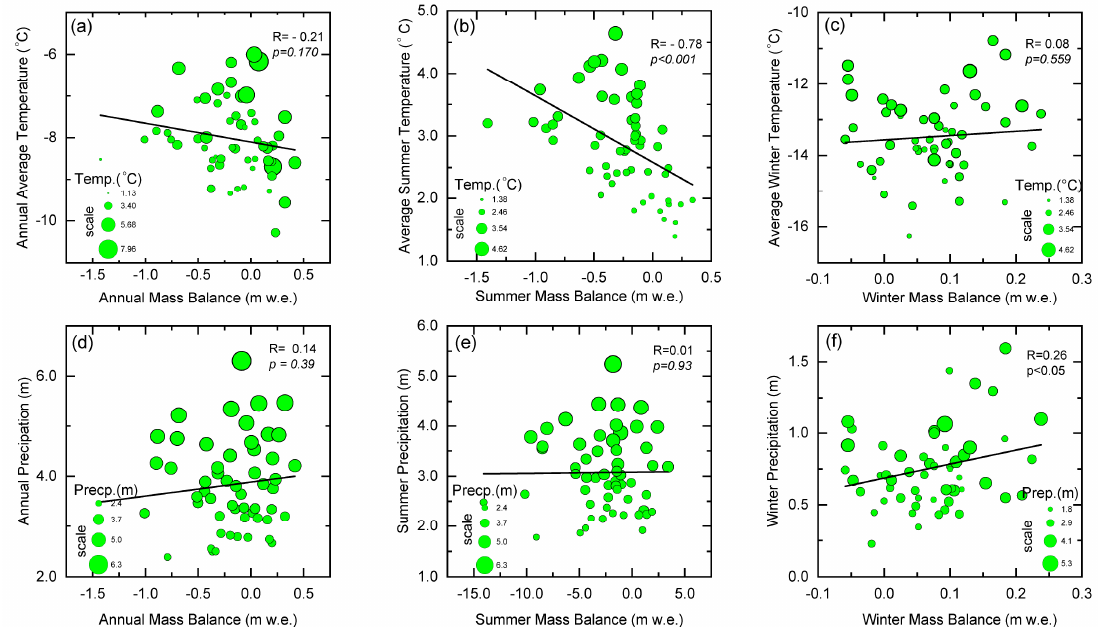
Figure 10. The glacier ablation and accumulation response to local air temperature and precipitation of TL station during 1957–2013. The relationship between annual mass balance and annual air temperature ( a ) and annual precipitation ( d ); the relationship between annual ablation in summer and summer annual mean air temperature ( b ) and summer precipitation ( e ); the relationship between accumulation in winter and winter mean annual air temperature ( c ); and annual precipitation ( f ). The solid lines in the figure indicate the linear rate for air temperature and precipitation.